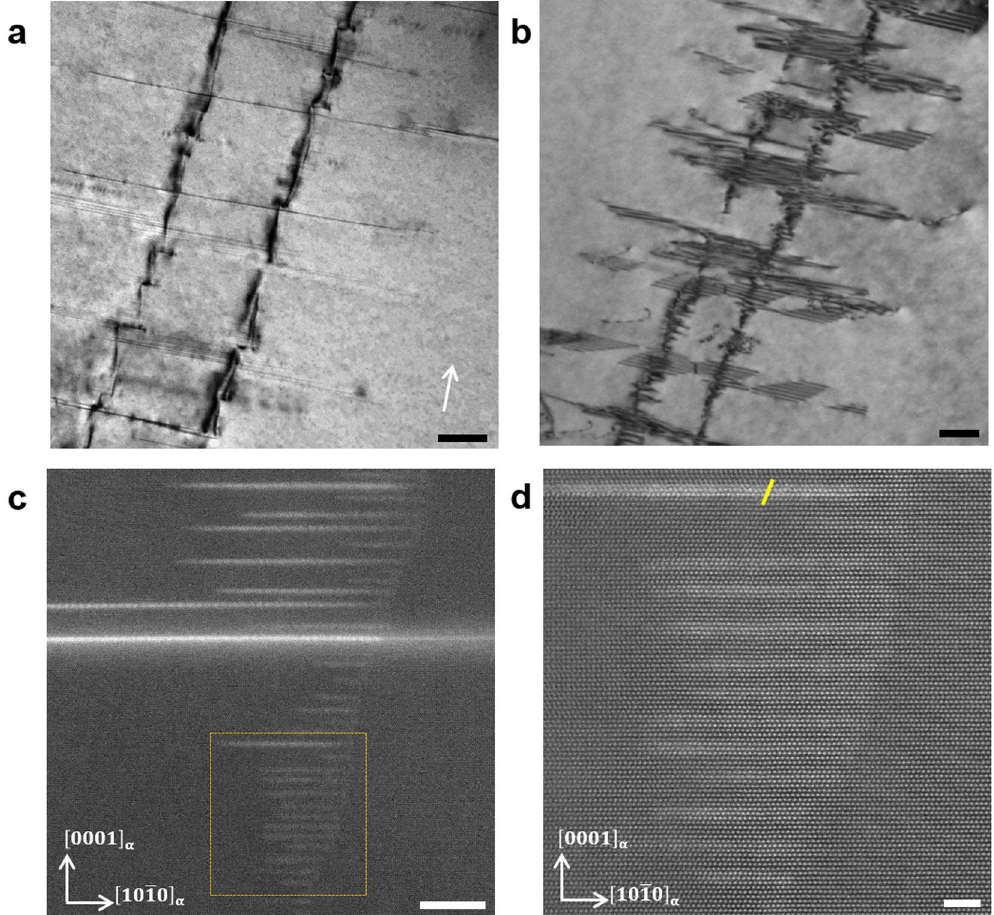
Figure 1. GP zones and LPSO building blocks in solution-annealed Mg-1Y-0.5Zn alloy. ( a ) TEM bright field image under two-beam condition with g = {0002} for Mg-1Y-0.5Zn alloy after solution annealing for 10 h at 500 °C followed by air cooling. Two main microstructural features can be seen in the Mg matrix: long plate-type defects along the basal plane and between the long plate-type defects strong strain contrast along the hcp c-axis (parallel to the white arrow). Beam direction is near [1210] . Scale bar width is 200 nm. ( b ) TEM bright field image of the same region as ( a ) under two-beam condition with g = (1011) , which reveals a more inclined view of the basal plane. The long plate-type defects along the basal plane in ( a ) show the contrast of stacking fault fringes together with some Shockley partial dislocations. The strong strain contrast in ( a ) shows the thin line contrast without the contrast of stacking fault fringes. Scale bar width is 200 nm. ( c ) HAADF-STEM image shows long plate-type defects and very thin defects with bright contrast, which indicates that the defects are enriched in Y/Zn atoms. Beam direction is [1210] . Scale bar width is 10 nm. ( d ) Enlarged HAADF-STEM image of the region marked by an orange square in ( c ). The uppermost basal plane defect with bright contrast shows a local fcc stacking sequence being structurally identical with LPSO building blocks. The yellow line illustrates the stacking sequence of the LPSO building block. The other thin basal defects are hcp-GP zones enriched in Y/Zn atoms. Beam direction is [1210] . Scale bar width is 2